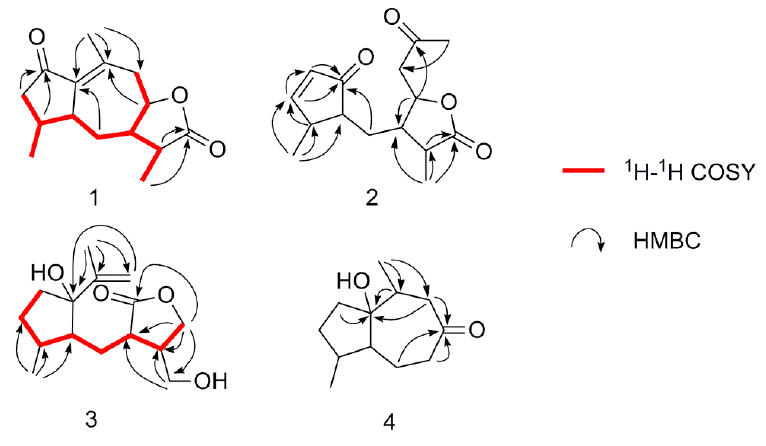
Figure 2. Selected key 1 H- 1 H COSY and HMBC correlations of compounds 1 – 4 .